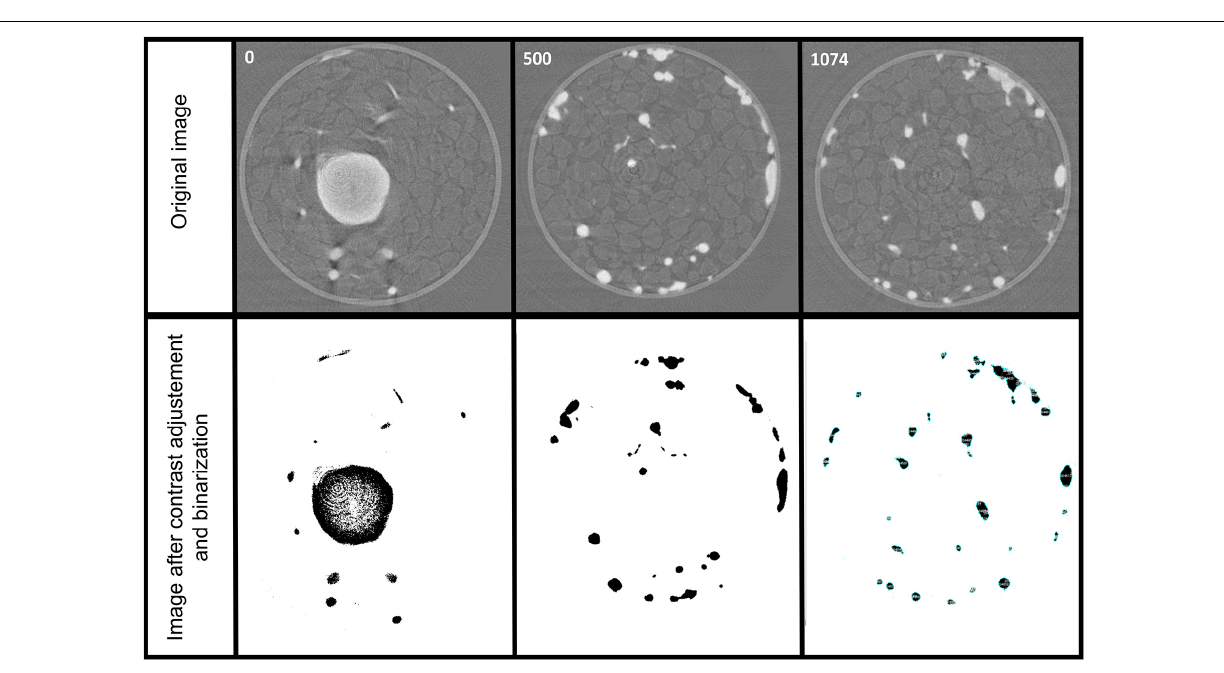
FIGURE 9 | Image analysis for quantification of the root system. A contrast adjustment and binarization is performed on the whole stack of the 1074 slides obtained after reconstruction to specifically select the roots and quantify them by the particle analysis toolbox of Image J free